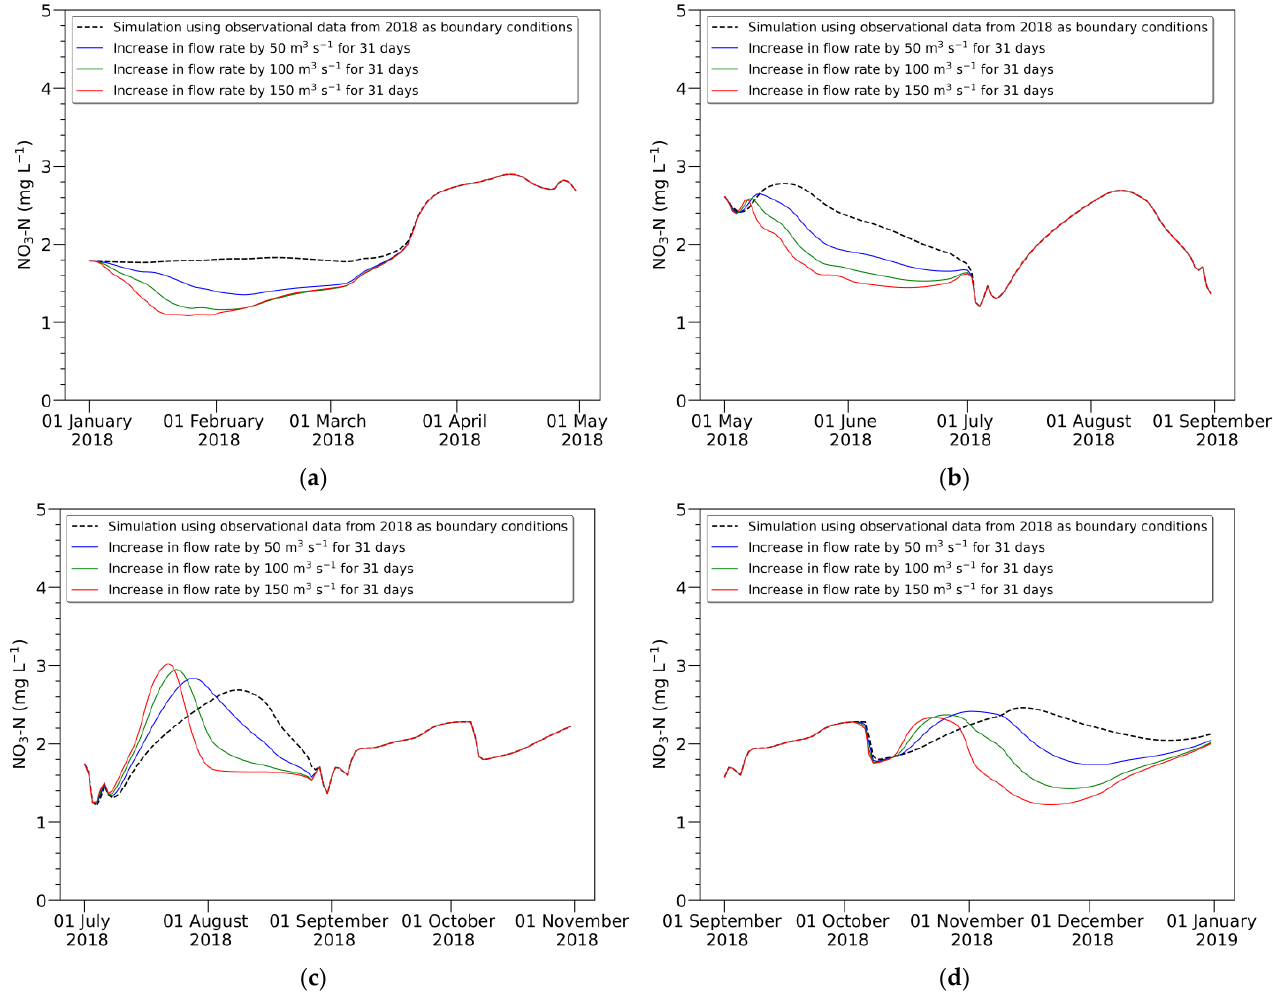
Figure 10. Changes in the NO 3 -N concentration in cross section 416 caused by variations in flow rate (50, 100, and 150 m 3 s − 1 ) at the upstream boundary for 31 days. The black graph shows the NO 3 -N concentration simulated using the observational data from 2018 as boundary conditions. The change in flow rate occurred in: ( a ) January; ( b ) May; ( c ) July; and ( d ) October.